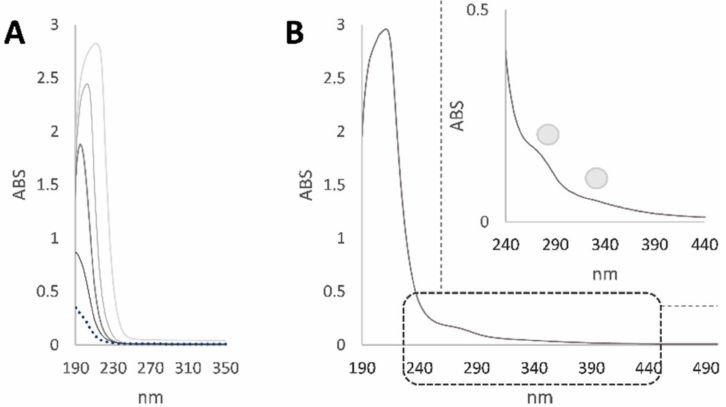
Figure 1. ( A ) UV spectra of lincomycin at different concentrations in the 25–500 mg/L range; ( B ) UV spectrum of tank water with an enlargement of the region between 240 and 440